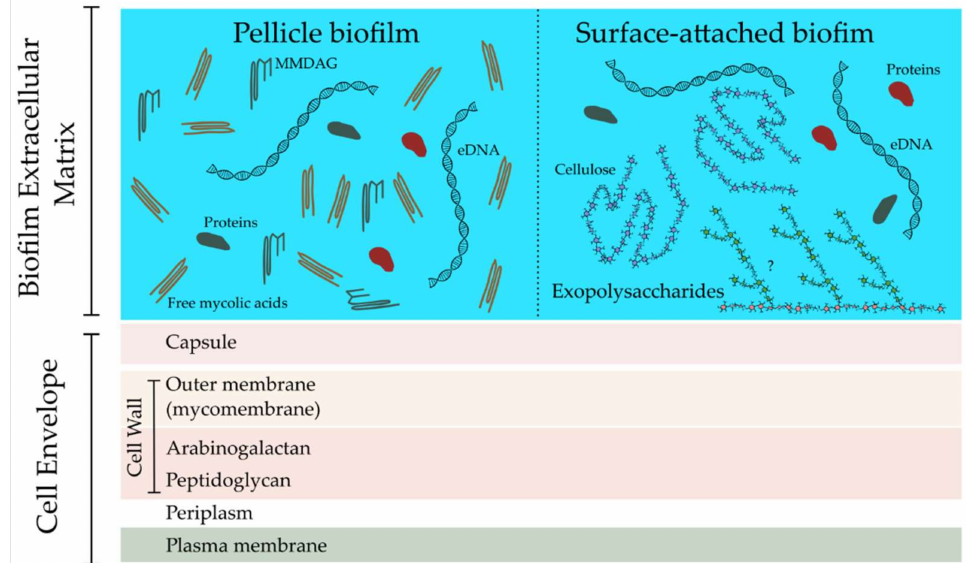
Figure 2. The composition of the biofilm extracellular matrix is different in pellicle biofilms and surface-attached biofilms. While the former is rich in free mycolic acids and monomeromycolyl diacylglycerol (MMDAG), the latter is lipid-poor and contains large amounts of exopolysaccharides. Both types contain extracellular DNA (eDNA) and